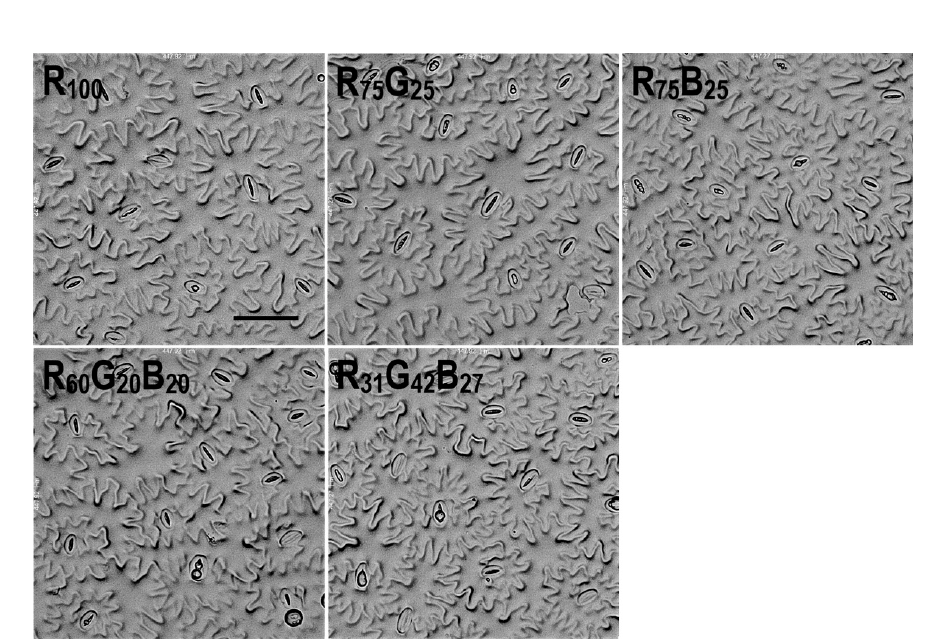
Figure 7. Effects of different spectral treatments on the stomatal development of Ocimum basilicum grown under five different combinations of red, green, and blue LEDs with the same light intensity for 14 days. The numbers after each waveband indicate the ratios of the intensities. The R 31 G 42 B 27 treatment mimics the sunlight spectrum measured in the experimental greenhouse. Scale bar is 100 µm. Light-induced stomatal responses are regulated by several photoreceptors, including blue/UV-A light-absorbing cryptochromes (CRY) and phototropins, and red/far-red light-